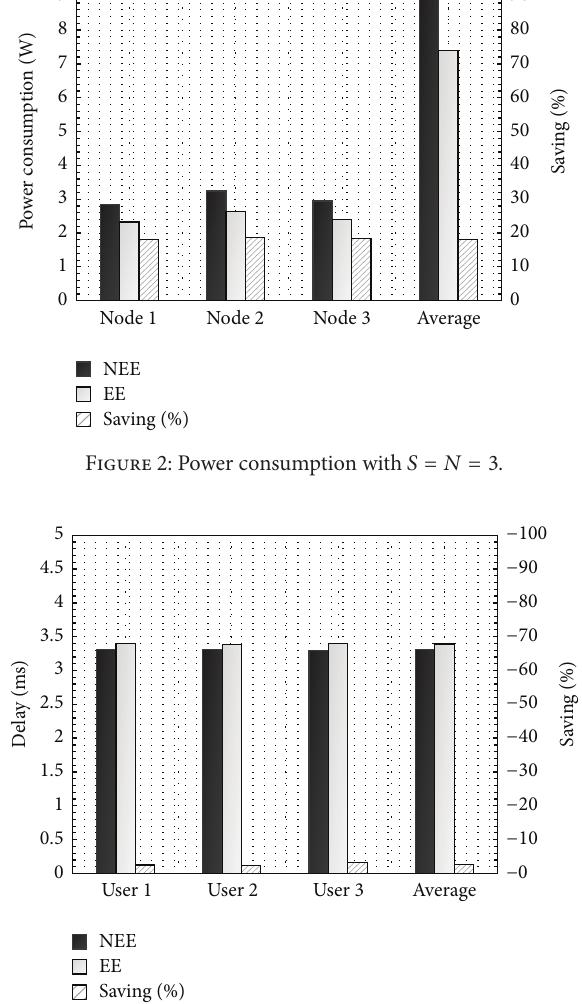
Figure 3: User (VNF) delays with 𝑆 = 𝑁 =